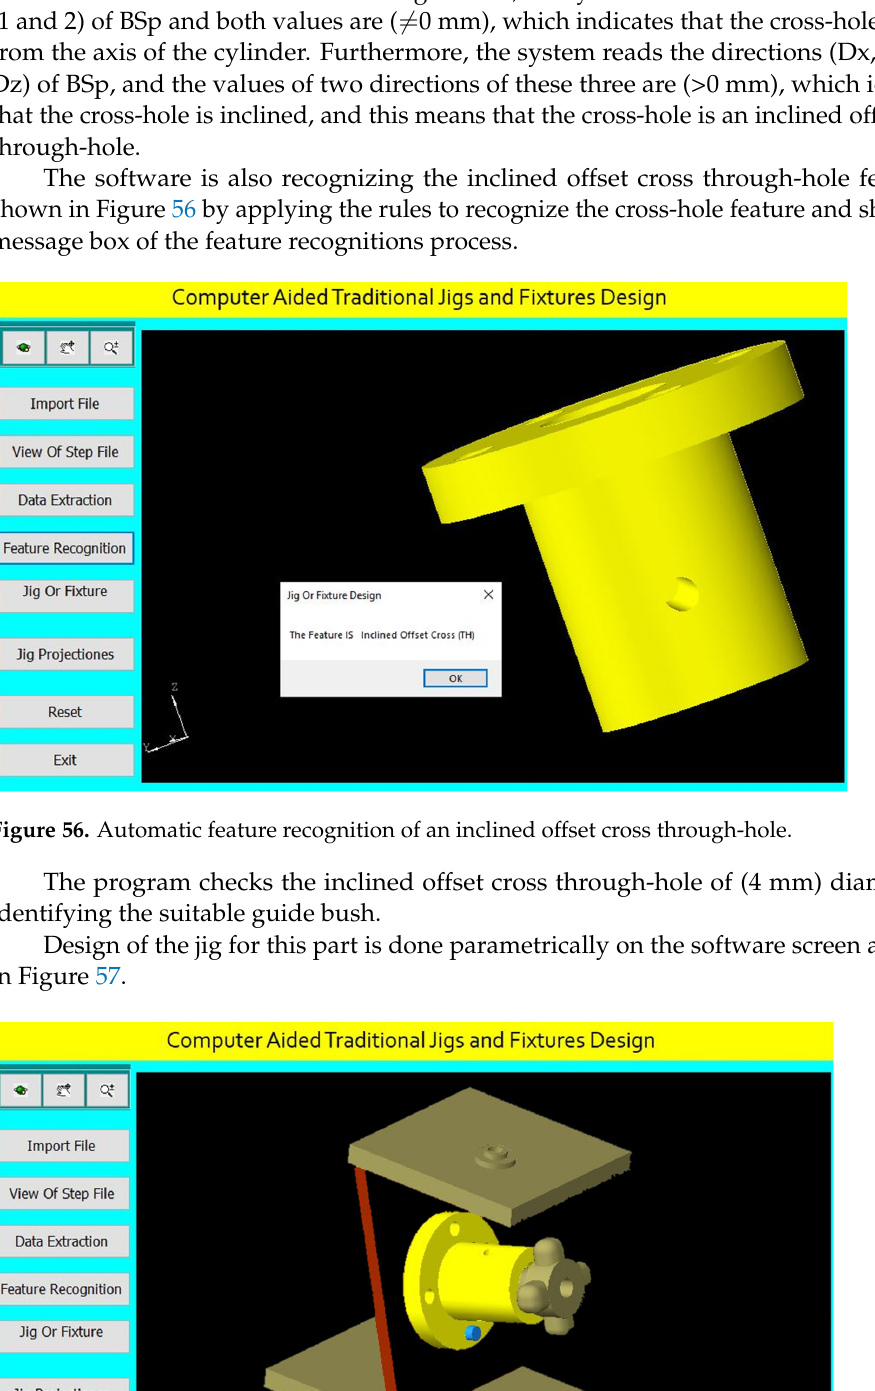
Figure 58. The jig views. 6. Design Verification For verifying the jig design, the jig dimensions are compared to the design rules for the part which identify the following: The jig height (H) = 2 Dmax (for the vertical jig).